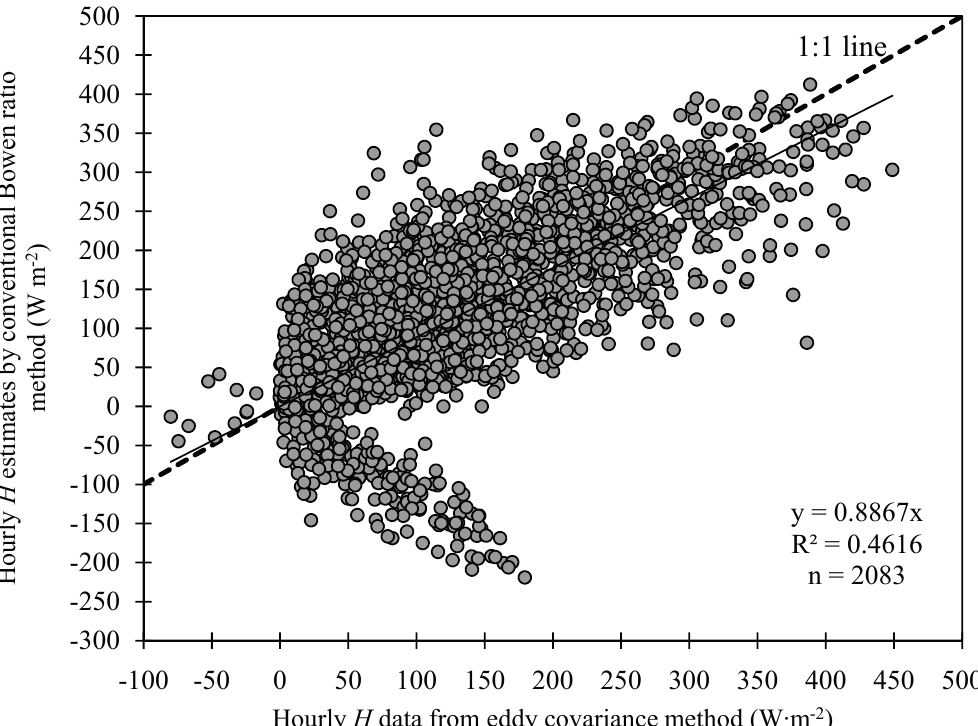
Hourly H data from eddy covariance method (W·m -2 )